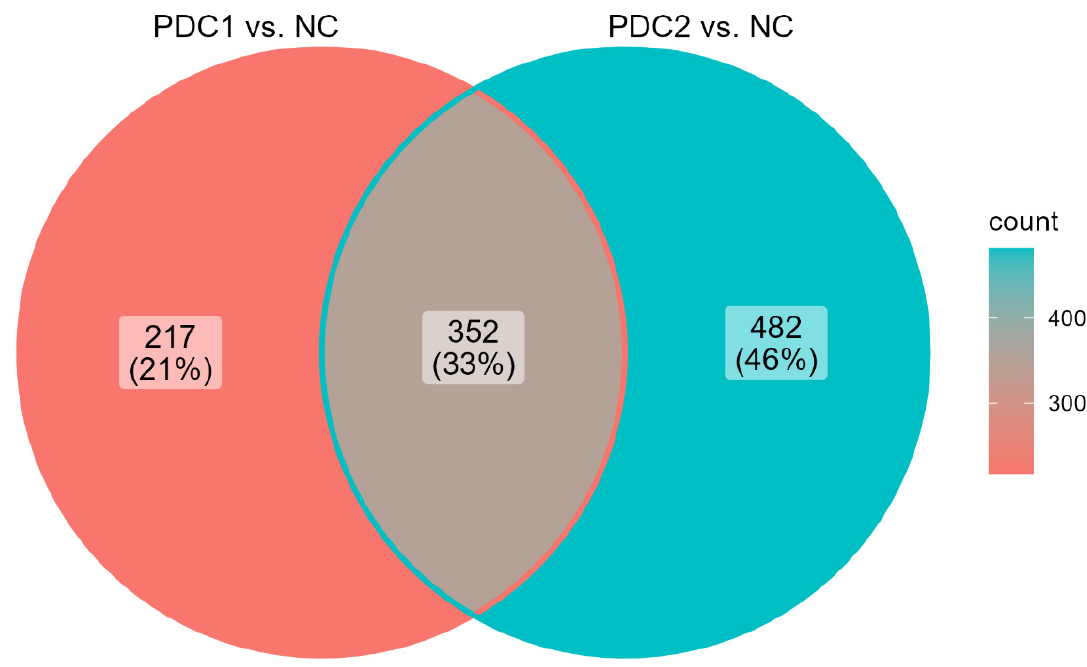
Figure 4. Venn diagram reporting the number of unique and overlapping DEGs found in PDC1 vs. NC and PDC2 vs. NC comparisons.